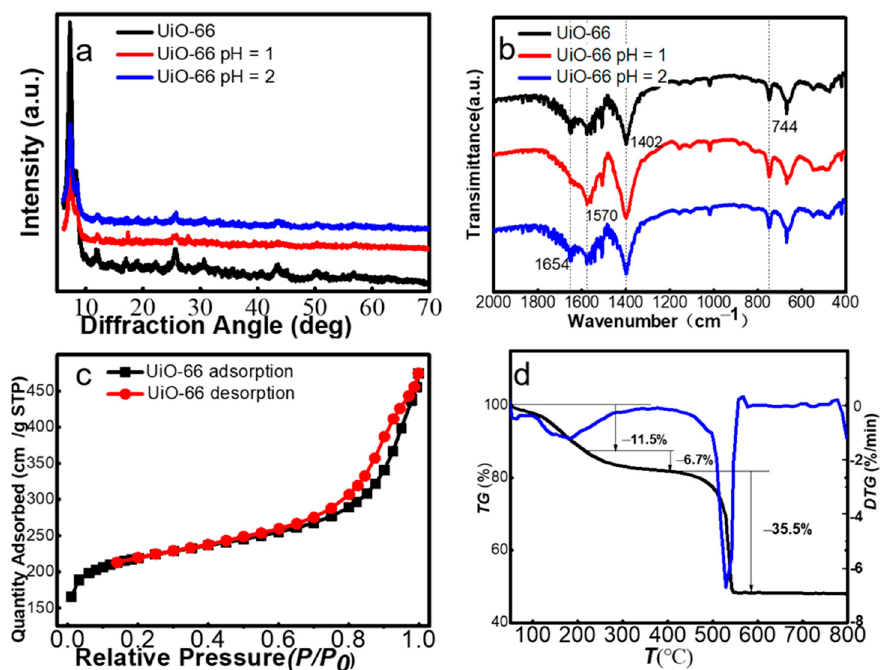
Figure 1. ( a ) XRD patterns of UiO-66 and UiO-66 after soaking in an acid solution of pH 1 and 2 for 12 h; ( b ) FT-IR spectra of UiO-66 and UiO-66 after soaking in an acid solution of pH 1 and 2 for 12 h; ( c ) N 2 adsorption-desorption isotherms of UiO-66; ( d ) TG and DTG curves of UiO-66.